Question: Write a single sentence explaining what this figure depicts.
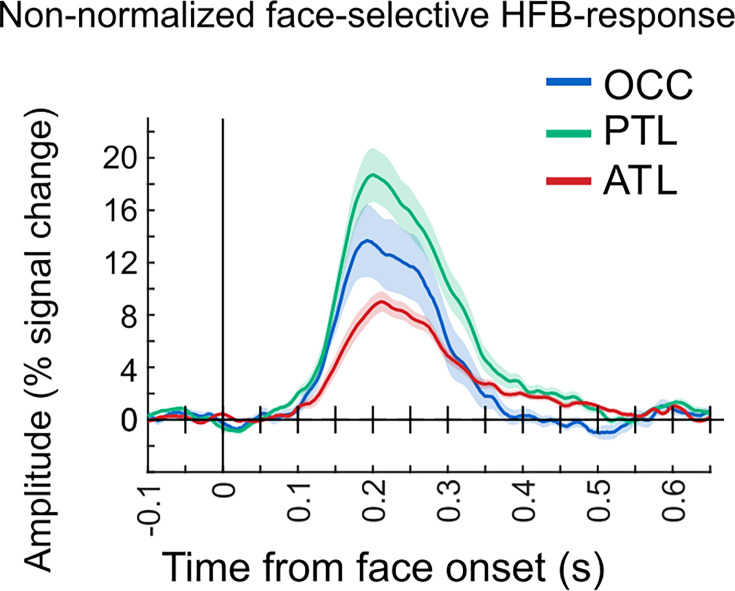
Answer: Non-normalized time-courses. Time-domain face-selective HFB activity in contacts showing response increase, averaged by main VOTC region (OCC, PTL, ATL) across hemisphere. HFB time-series were notch-filtered to remove the general visual response at 6 Hz and harmonics, leaving only face-selective signals. Time-series are original non-normalized versions of Figure 4 of the main text. Shaded area represents the standard error of the mean between participants.